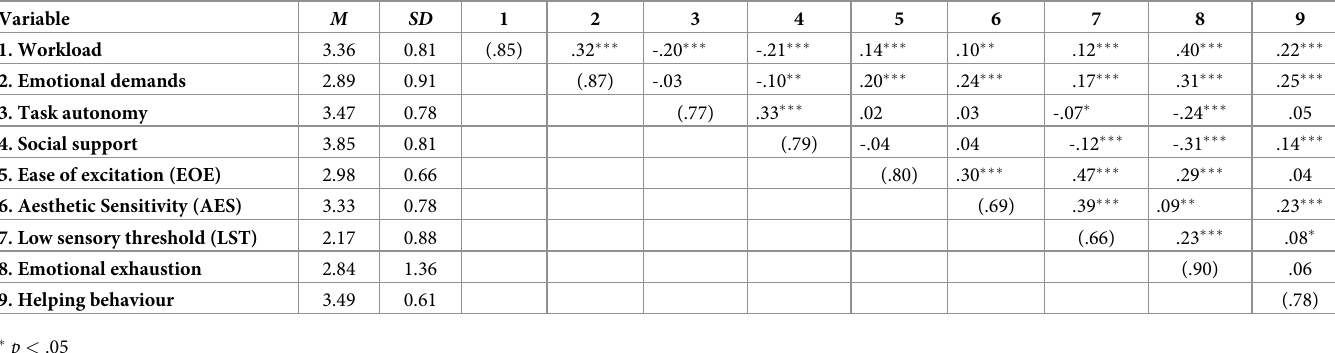
Table 1. Means, standard deviations, cronbach’s alpha coefficients and correlation matrix ( N = 1019). Variable